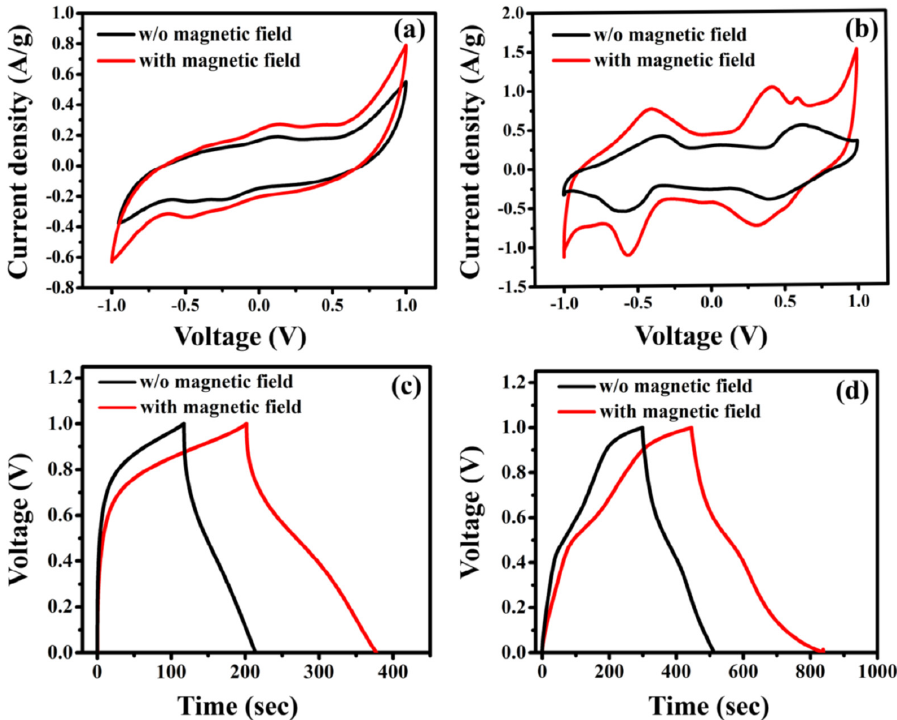
Figure 17. CV and GCD curves of ( a , c ) Fe 3 O 4 and ( b , d ) Fe 3 O 4 /RGO with and without magnetic field. Reproduced with permission from [144] Copyright (2018) IOP Publishing.